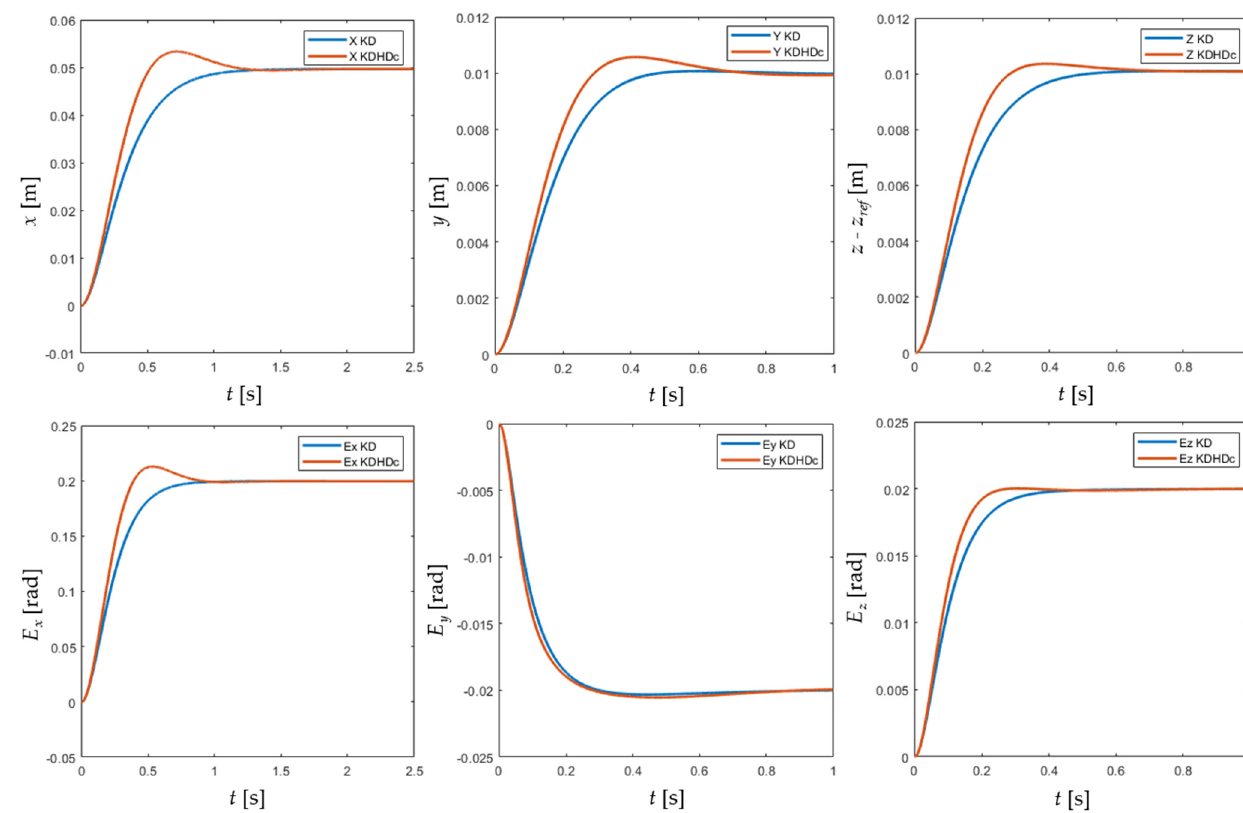
Figure 5. Case study B, KD–KDHDc comparison, external coordinates.